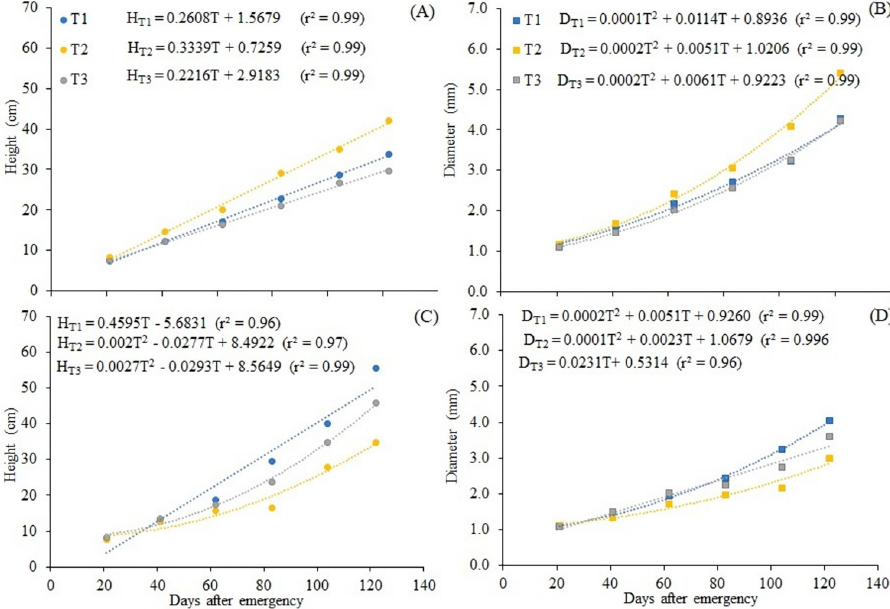
Fig 4. Growth of D . nigra seedlings in height and diameter as a function of the days after emergence (DAE), produced under full sun (A and B) and 50% cover (C and D). ( � p < 0.05).